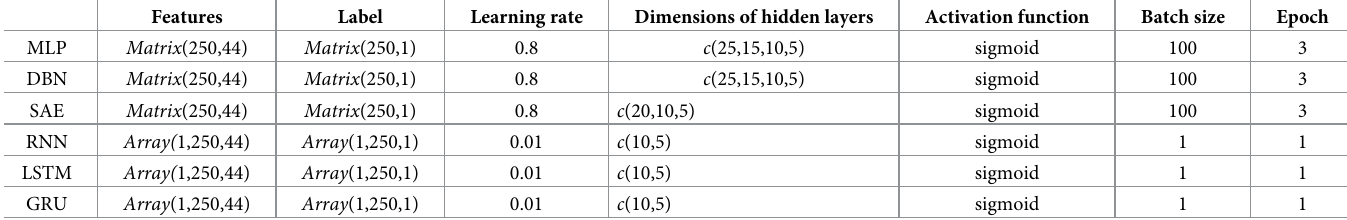
Table 2. Parameter setting of deep neural network algorithms.